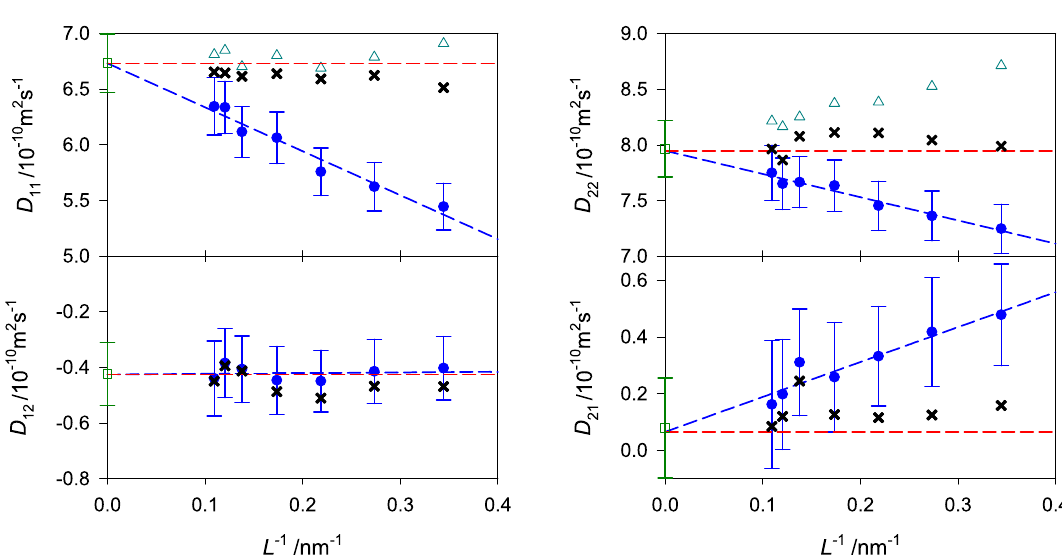
Figure 13. Elements of the Fick diffusion coefficient matrix of the ternary subsystem water (1) + ethanol (2) + 2-propanol (3) ( x H2O = 0.125 , x C2H6O = 0.625 and x C3H8O = 0.25 molmol − length of the simulation volume L at 298.15 K and 0.1 MPa. The blue dashed line is a linear fit to the uncorrected simulation results (blue bullets). The coefficients calculated with the corrected values using the fast correction procedure 12 (crosses) are compared with those according to the procedure by Jamali et al. 71 (cyan triangles). The green squares represent the Fick diffusion coefficient values based on the individually extrapolated phenomenological